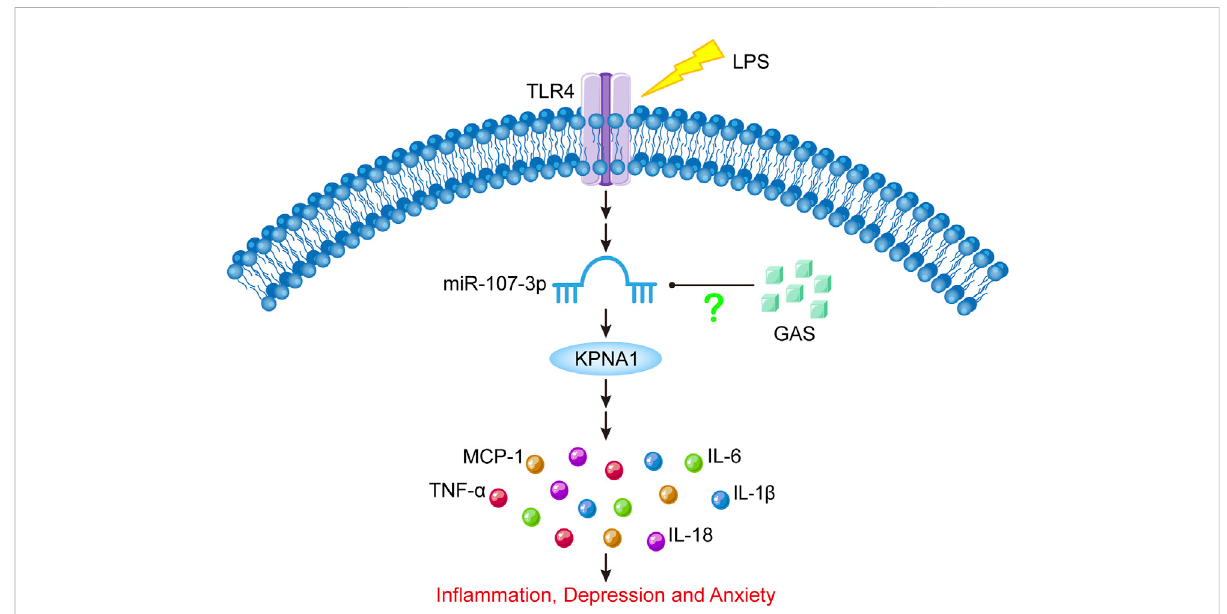
FIGURE 8 Schematicdiagramofthepresentexperimentalresults.LPSstimulationcanincreasemiR-107-3p,thuspromotingtheexpressionofKPNA1,and ultimately promoting the production of in fl ammatory cytokines, which leads to in fl ammatory response and depressive-like behavior. GAS can downregulate the expression of KPNA1 by inhibiting miR-107-3p, reducing the production of in fl ammatory factors, and alleviating in fl ammatory response and depressive-like behavior. LPS: lipopolysaccharide; GAS, gastrodin; KPNA1, Karyopherin Subunit Alpha1; IL-1 β , Interleukin-1; IL-6, Interleukin-6; IL-18, Interleukin-18; Tumor necrosis factor- α , TNF- α ; MCP-1, Monocyte Chemoattractant Protein-1; TLR4, toll-like receptor